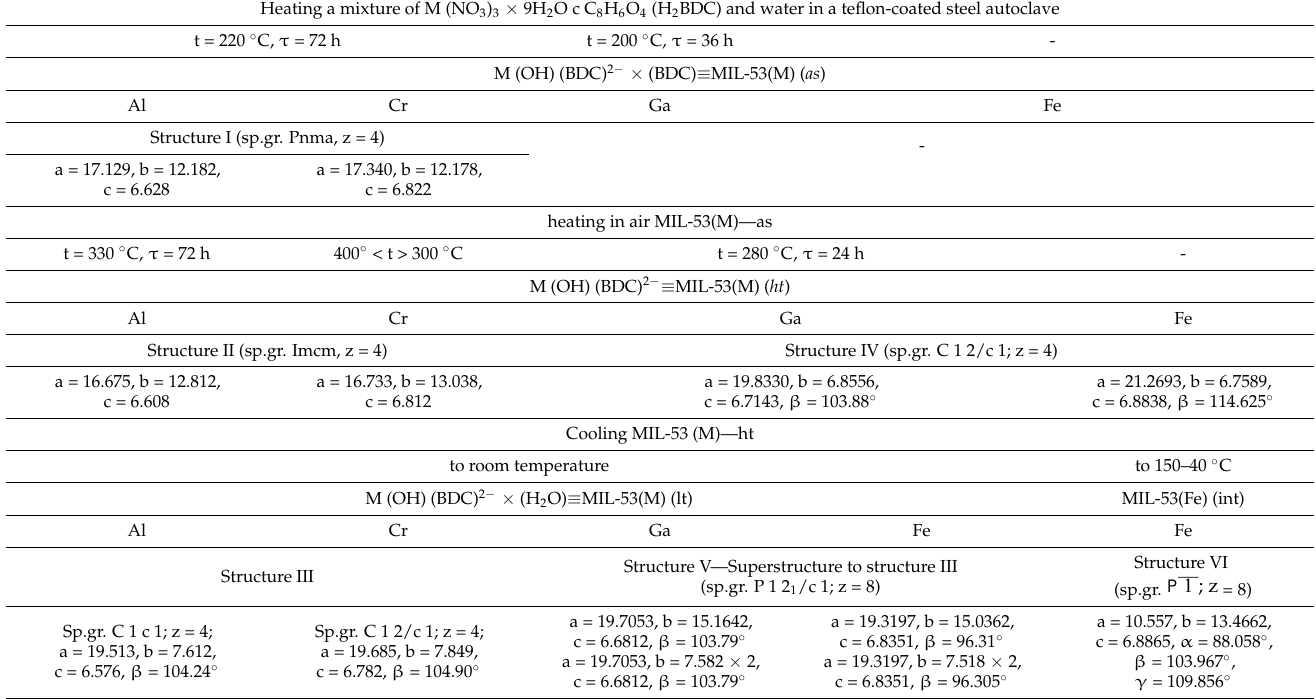
Table 1. Conditions for obtaining MIL-53(M 3+ ) and their structural characteristics [7–10].